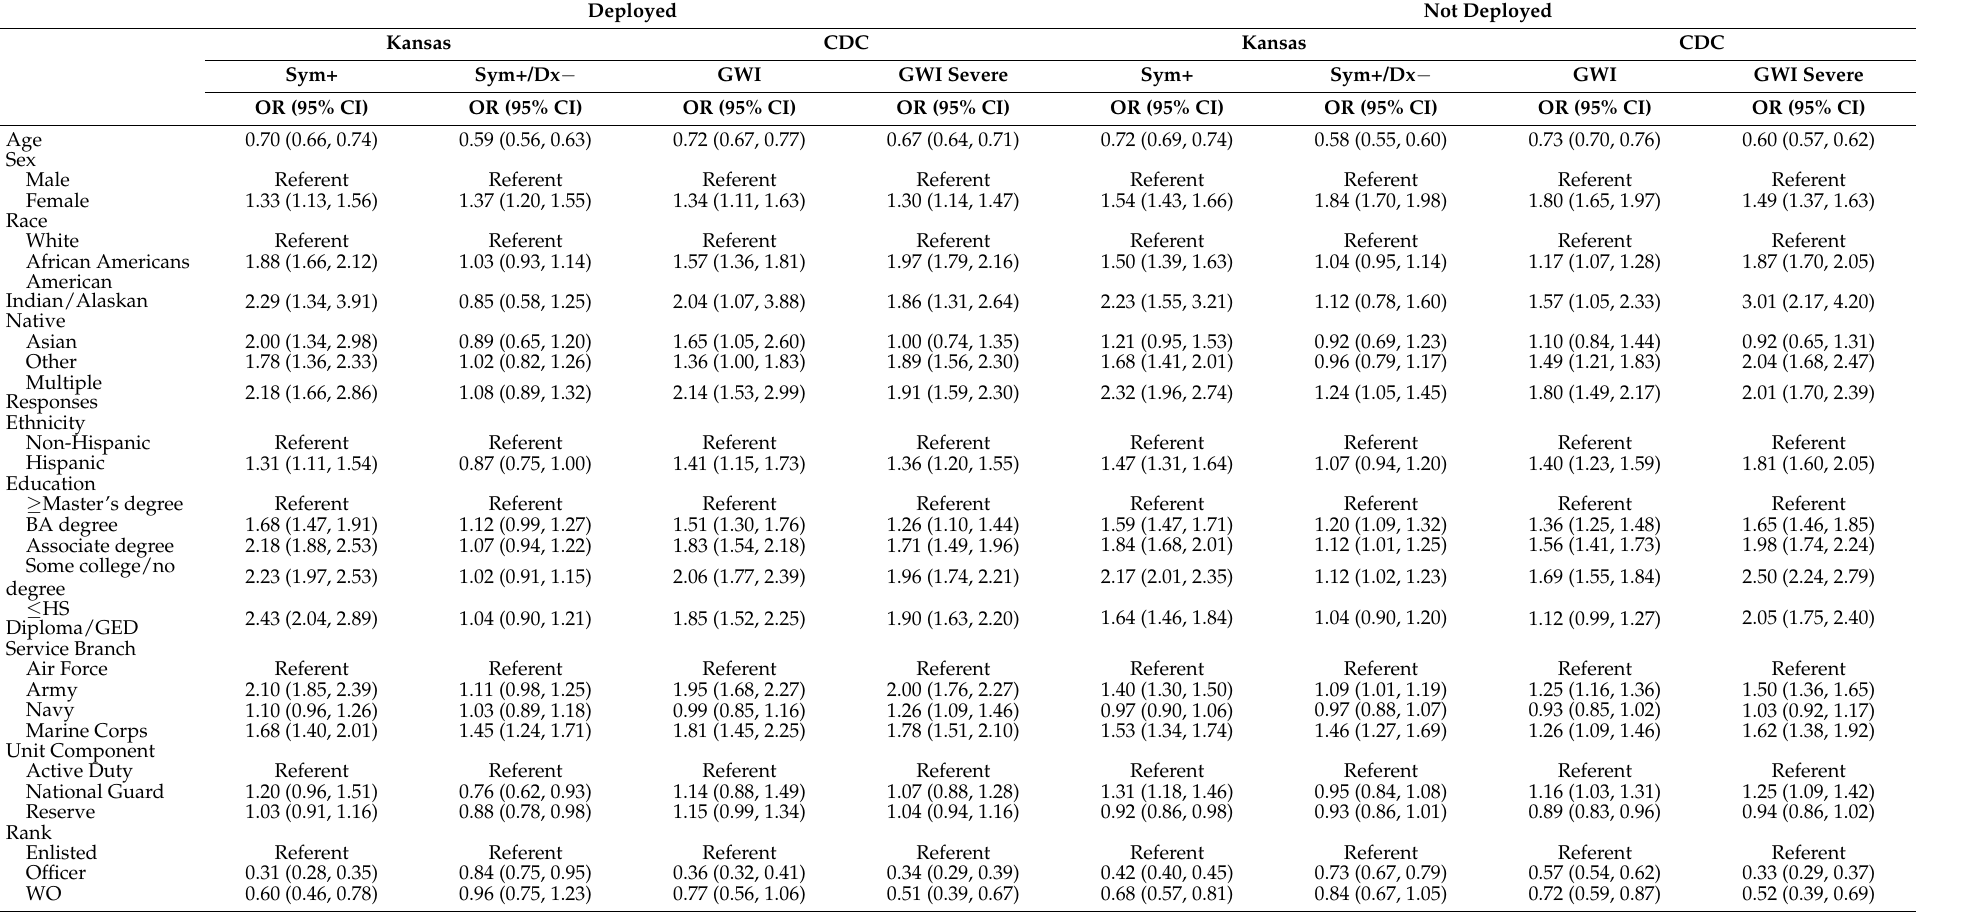
Table A2. Unadjusted Associations of Gulf War Illness Phenotypes with Demographic Characteristics. Deployed Not